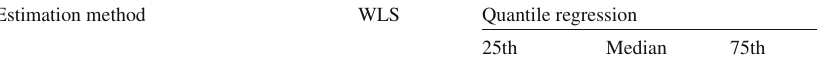
Table 6 The impact of exemption on expenditure growth, accounting for age-specific trends Estimation method WLS Quantile regression 25th Median